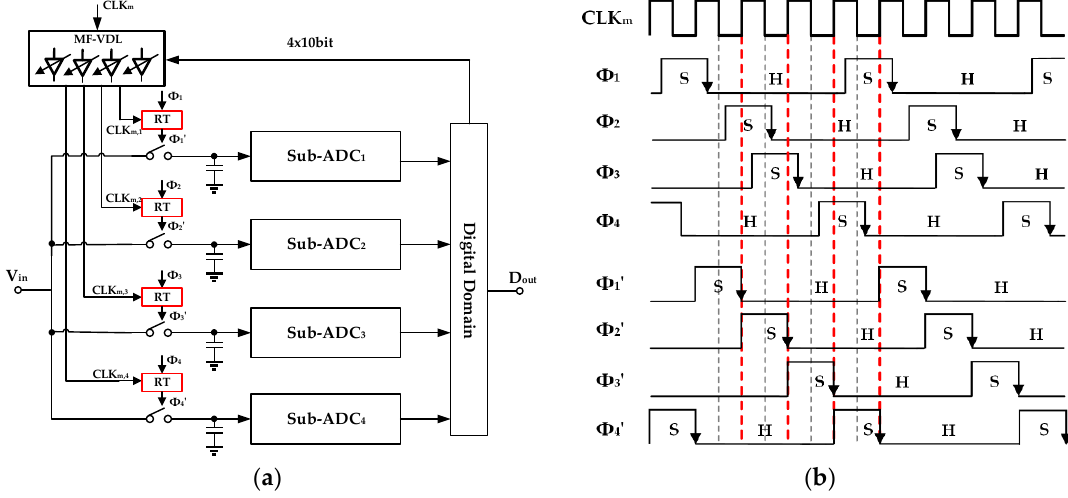
Figure 10. ( a ) Block diagram of the retiming scheme; ( b ) Timing diagram of sub-ADC sampling clock before and after retiming.